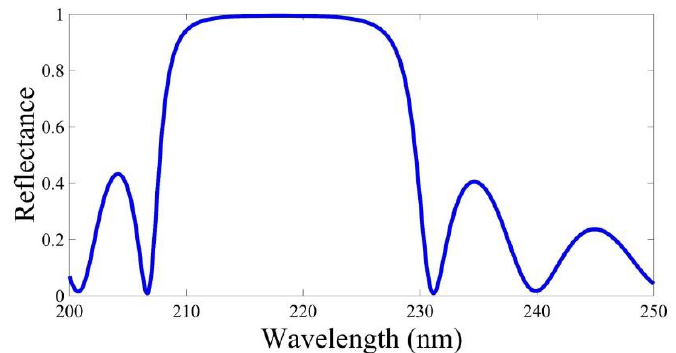
Figure 2. The reflectance of the proposed APC with air core radius ρ 0 = 5 cm and unit cell layers’ thicknesses d 1 = 29 nm, d 2 = 33.5 nm, and periodicity number N = 20.